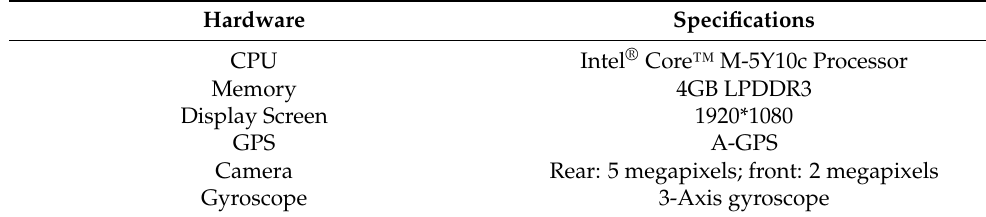
Table 1. Basic information of the tablet.